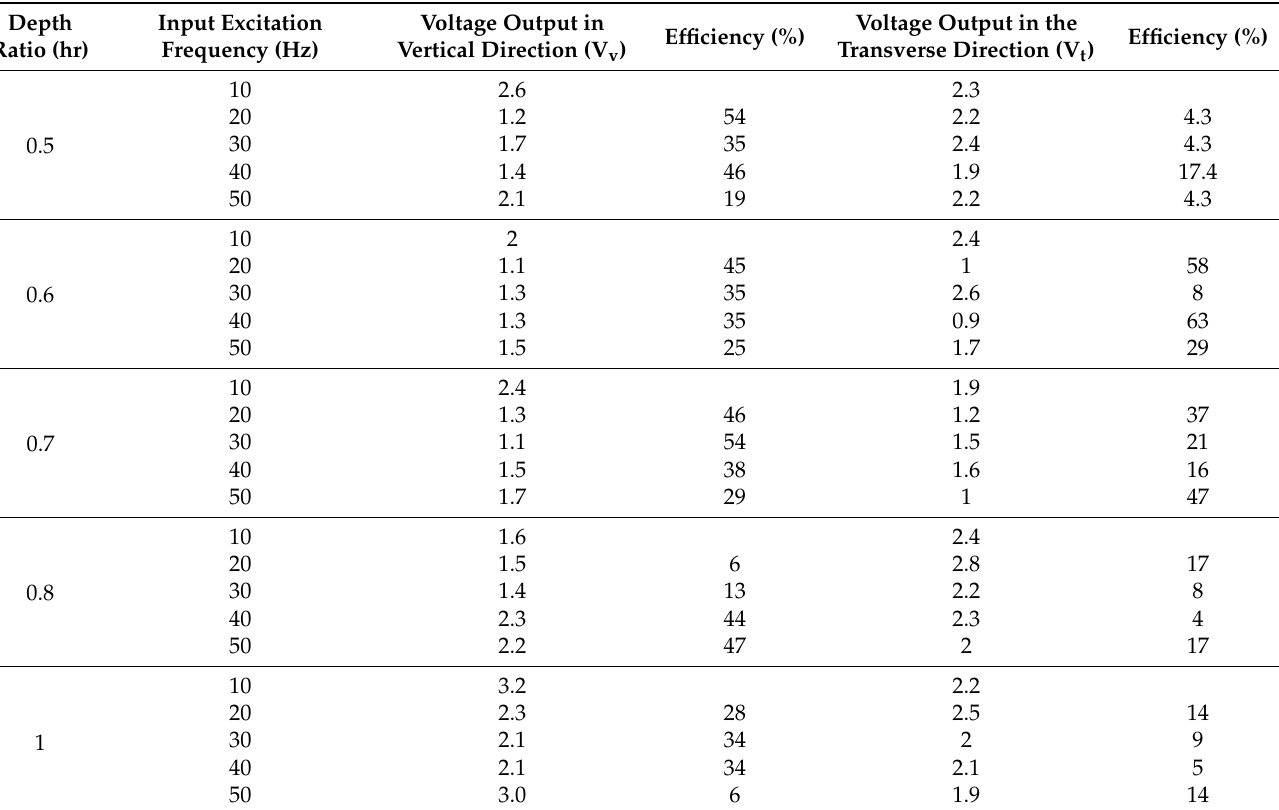
Figure 7. Output voltage for PZT patches embedded at varying depths in the vertical direction. Table 6. Voltage output efficiency of PZT patch embedded in poorly graded soil for various excitation